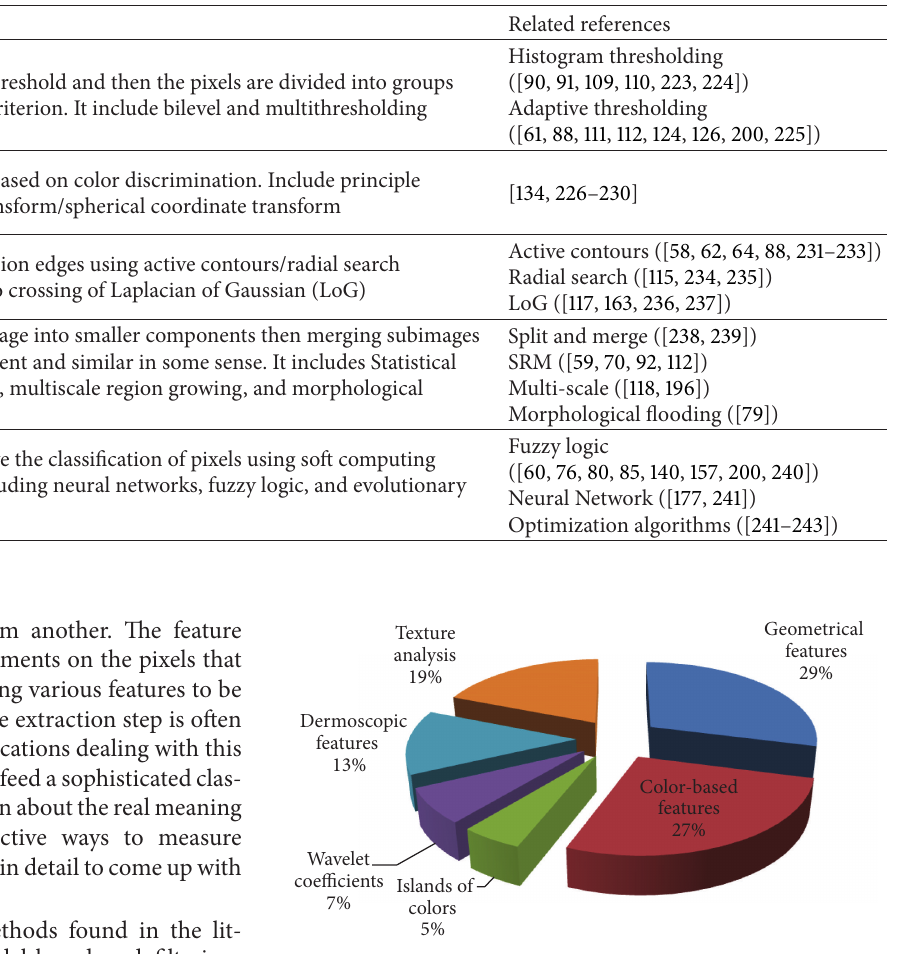
Figure 2: Illustration of feature distribution used in dermoscopic studies in the